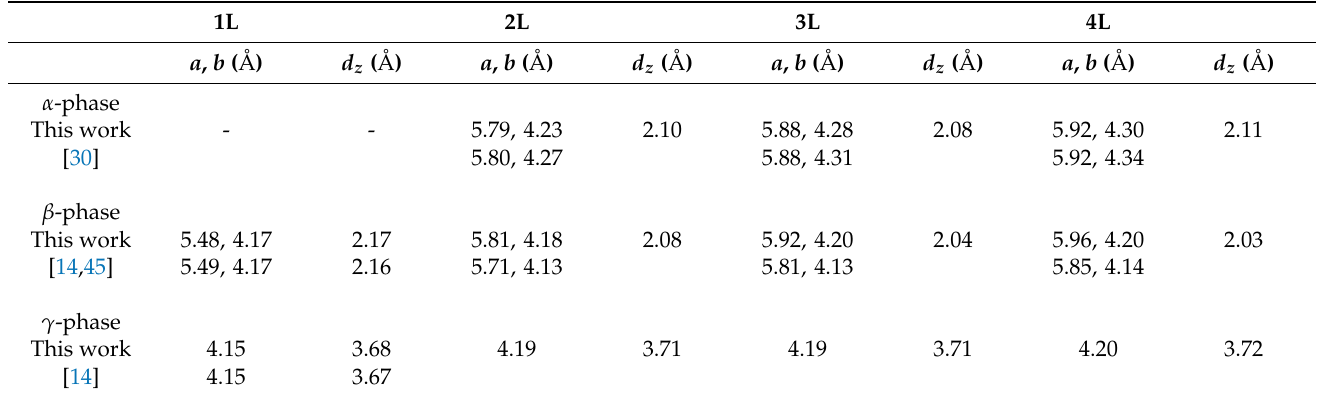
Table 1. Optimised lattice parameters ( a , b ) and (average) buckling parameter ( d z ), for increasing number of layers, of the three studied phases. Results from the literature are also reported below each related value. Note that ML α -Te is unstable. In the case of γ -phase, a = b . 2L 3L